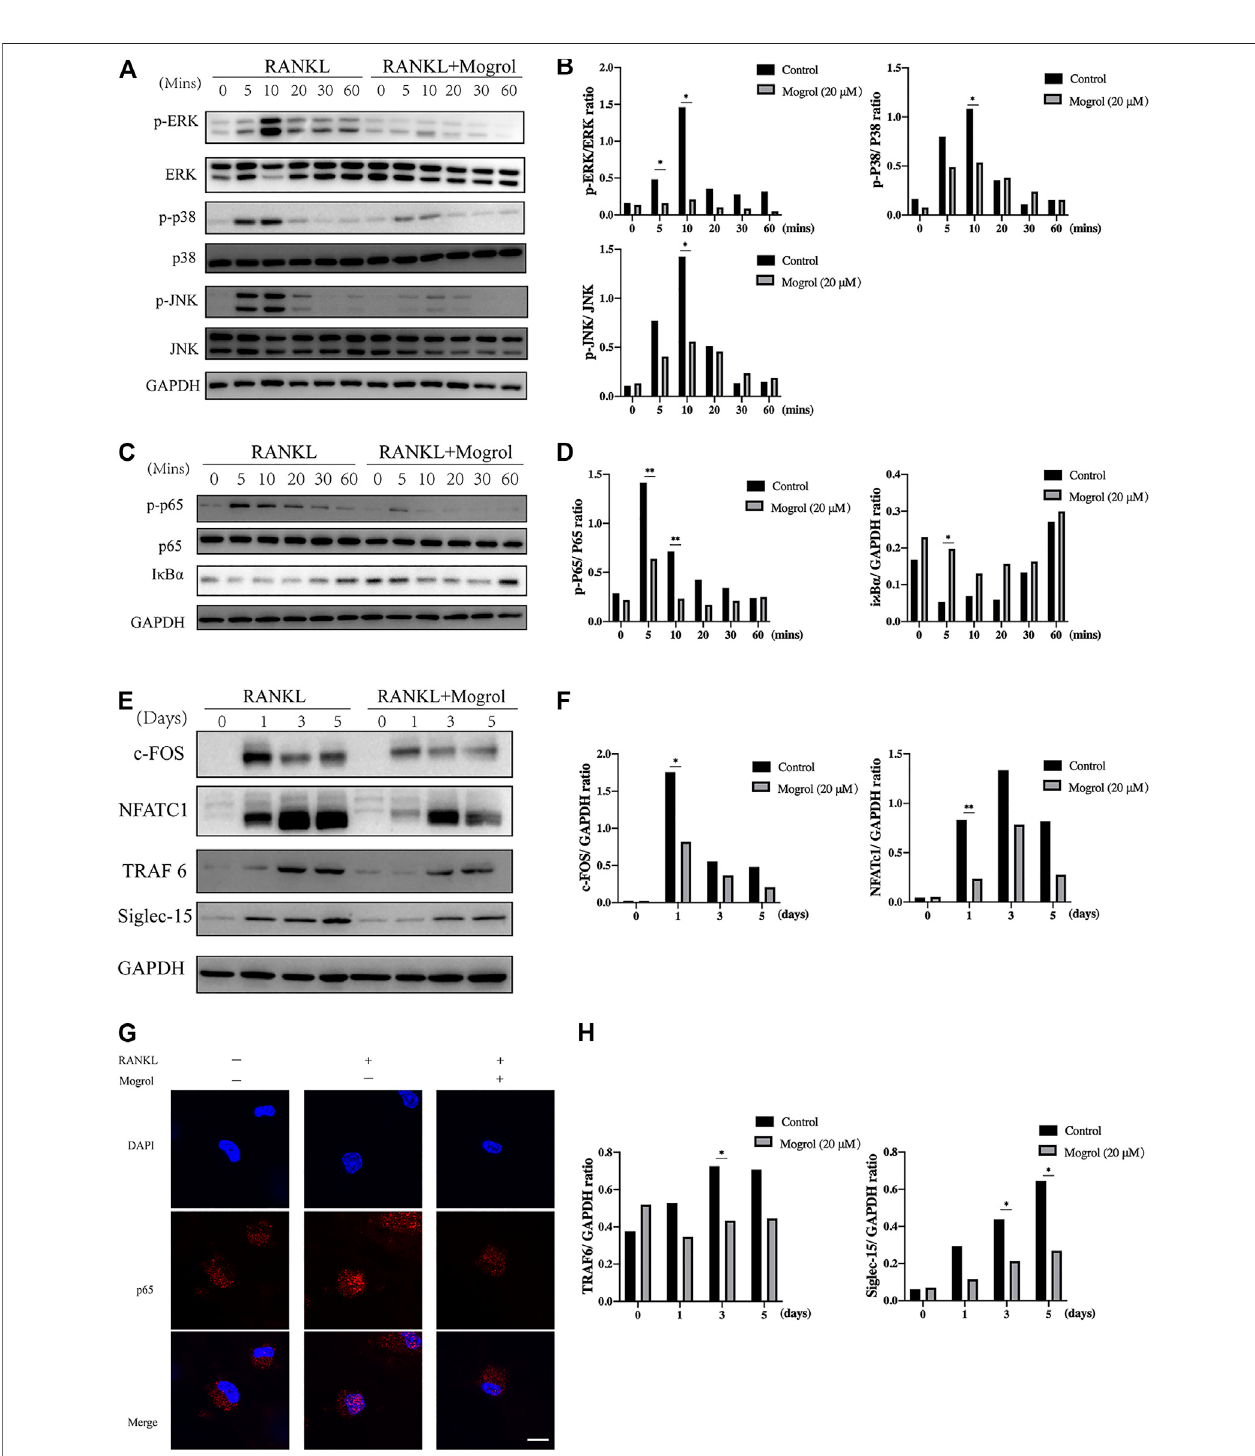
FIGURE 5 | Mogrol inhibited the RANKL-dependent TRAF6/NF- κ B/MAPK signaling pathways. (A) The impact of mogrol on RANKL-induced activation of ERK, JNK, and p38. BMMs were starved for 4 h with or without 20 μ M mogrol following activation with 50 ng/ml RANKL at various time points (0, 5, 10, 20, 30, or 60 min). Speci fi c antibodies were employed to identify the total and phosphorylated forms of ERK, JNK, and P38. (B) Phosphorylated ERK, JNK, and P38 Gy levels were quanti fi ed and normalized to total proteins. (C) RANKL-induced NF- κ B p65 phosphorylation and I κ B α degradation after mogrol treatment. (D) Using ImageJ, the gray levels ofp65 orI κ B α were measured and normalized toGAPDH ( n = 3). (E) BMMs werecultivatedwith or withoutmogrol for 0, 1,3, and 5 days withthe stimulation of RANKL. The proteins were identi fi ed with antibodies against NFATc1, c-Fos, TRAF6, Siglec-15, or GAPDH. (F,H) The relative expression of NFATc1, c-Fos, TRAF6 and Siglec-15 normalized to GAPDH was quanti fi ed by the gray level using ImageJ. (G) Nuclear translocation of P65 was determined by immuno fl uorescence staining using a p65 antibody and secondary antibody (red) and observed using a confocal fl uorescence microscope. Scale bar = 50 μ m.